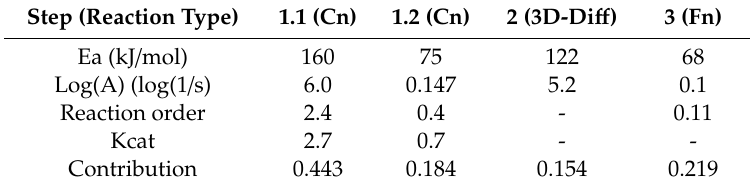
Table 3. Kinetic parameters used in the model for the thermal decomposition of PEEK under 2%